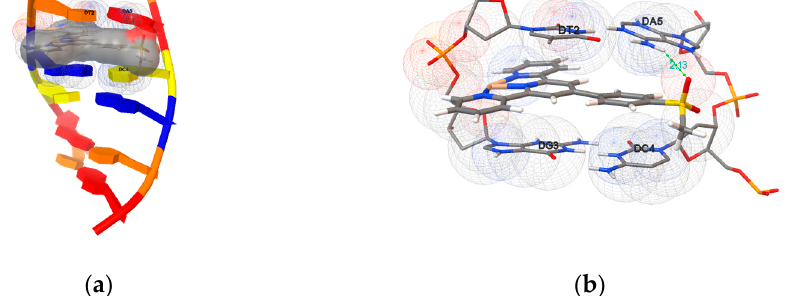
Figure 10. ( a ) The most favorable orientation and ( b ) enlarged view of compound 2f intercalating with the DNA (4JD8). The formed hydrogen bond and distance have been marked . Table 3. Hydrogen bond interactions for compounds 2a – 2c , 2f and 2g .